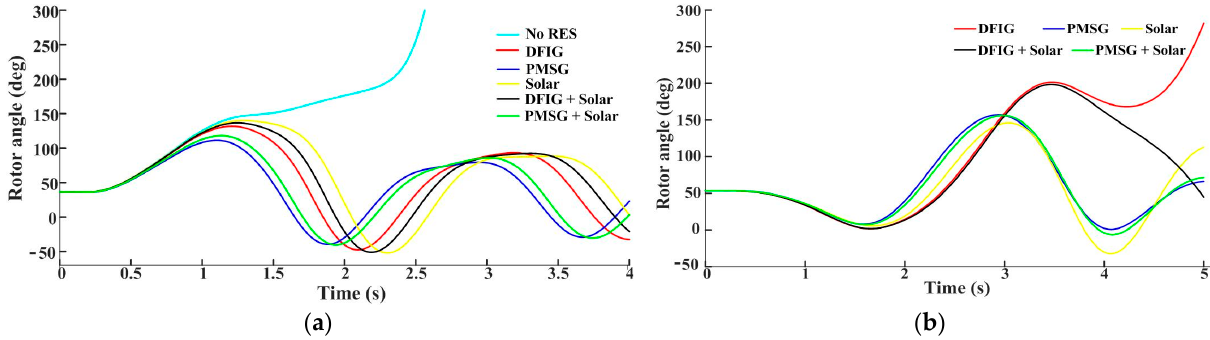
Figure 13. Variations in rotor angle when the fault is at bus 53 with: ( a ) conventional control and ( b ) proposed control (ARS). Table 3. CCT with conventional and proposed control when connected to different RES.